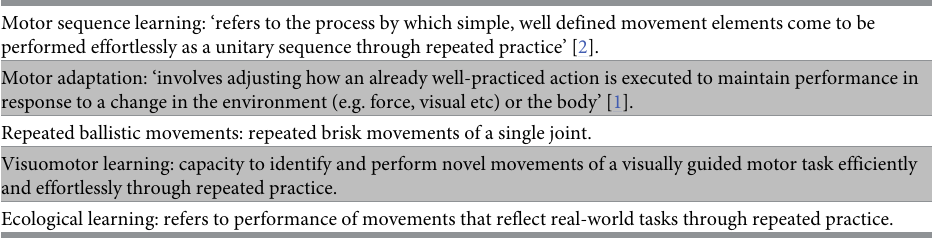
Table 1. Classification of motor